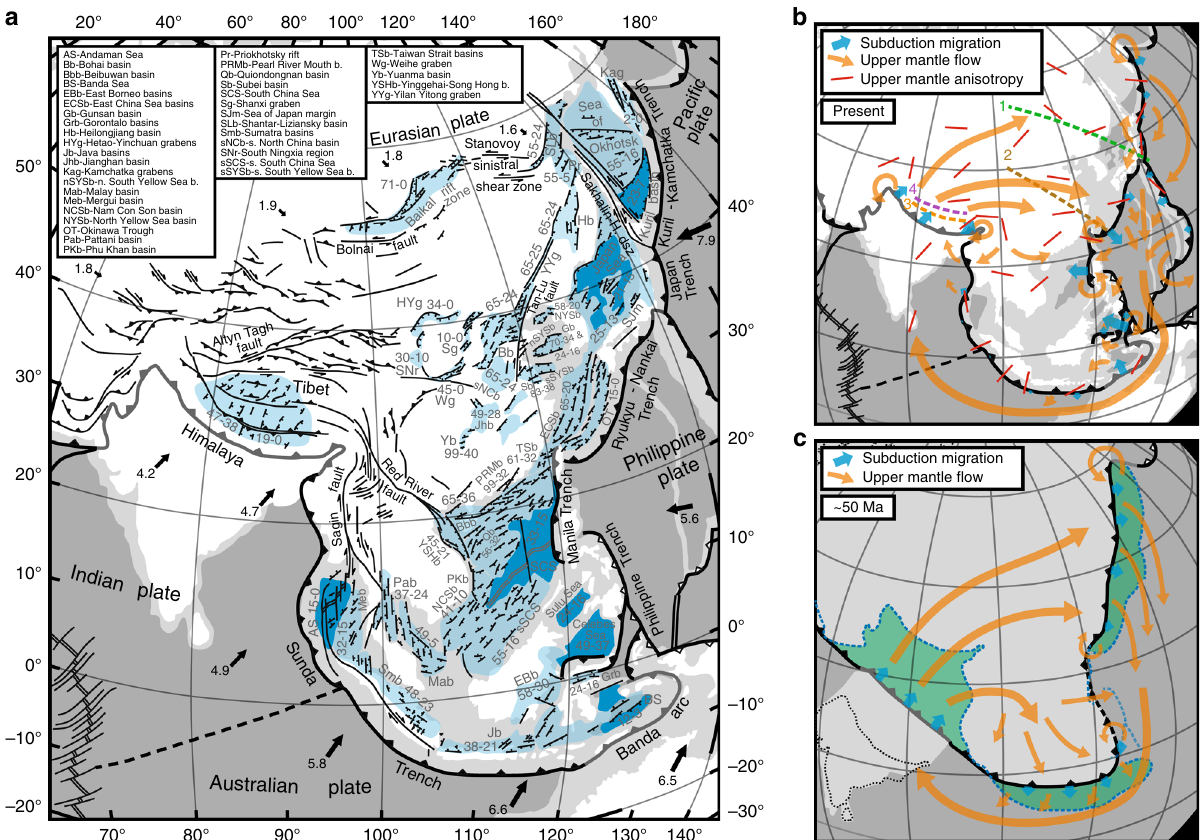
Fig. 1 Structural-tectonic maps showing widespread Cenozoic continental deformation in Central, East and Southeast Asia. a Structural-tectonic map showing structures and ages of extensional basins (see Supplementary Note 1). Arrows indicate present-day plate velocities (in cm year − 1 ) in the Indo- Atlantic hotspot reference frame 81 . Numbers next to extensional structures/basins indicate timing of extensional activity (in Ma). Light blue areas represent extended continental crust, dark blue areas represent backarc/marginal basin oceanic crust. b , c Present-day tectonic setting and simpli fi ed tectonic reconstruction at ~50 Ma of Central, East and Southeast Asian convergent plate boundaries showing oceanic/continental subduction zone migration (blue arrows) and proposed large-scale upper mantle fl ow patterns (orange arrows) that accommodate lateral slab migration (Indian continental slab advance and predominant retreat for oceanic slabs). Red bars in b indicate regional pattern of upper mantle anisotropy based on seismic shear wave splitting measurements derived from various sources 45,46,49,82 . Dashed lines with numbers 1 – 4 in b indicate sections along which Cenozoic fi nite extension has been estimated (see “ Methods ” ). Blue dashed lines in c indicate present-day position of main Asian convergent boundaries to illustrate fi nite plate boundary migration since ~50 Ma. Green areas in c illustrate surface areas of upper mantle volumes displaced since ~50 Ma by lateral slab migration. The simpli fi ed reconstruction in c is based on earlier reconstructions for the Himalaya – Tibet region and Southeast Asia 74,75 , for the East China region 17 , for the Japan region 76,77 and for the Kuril-Kamchatka-Sea of Okhotsk region